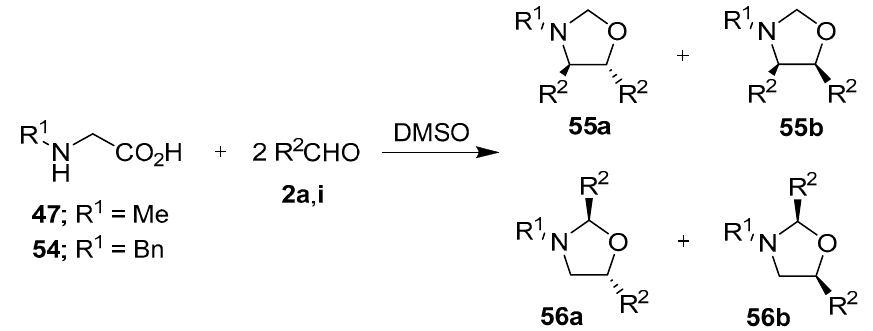
Scheme 13. Reactions of N -substituted glycine derivatives 47 or 54 with aldehydes 2a and 2i to afford the respective 4,5- and 2,5-disubstituted-1,3-oxazolidines 55 and 56 . Table 8. Reaction between glycine derivatives 47 or 54 and aromatic aldehydes 2a or 2i (Scheme 13). Entry